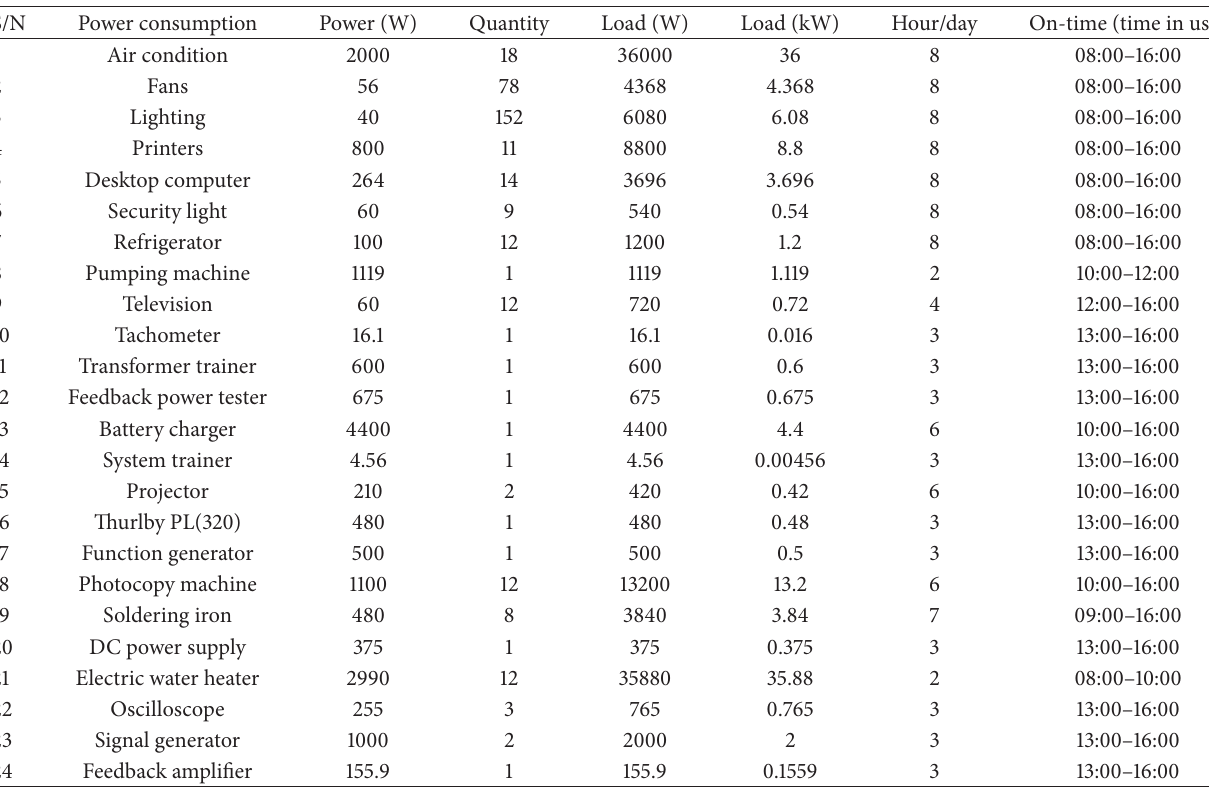
Table 1: Remote station daily load demand.